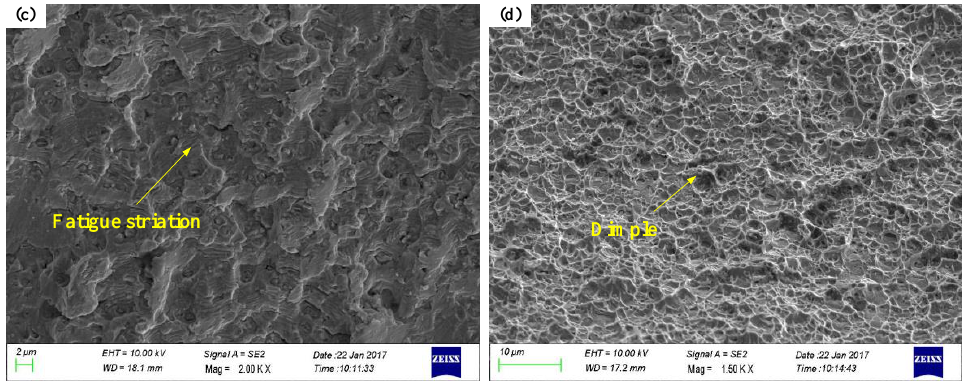
Figure 13. Fracture surface of TCPA specimen ( R a = 0.053 µm): ( a ) overview of fracture surface; ( b ) Crack nucleation site; ( c ) fatigue striations and ( d ) dimples.